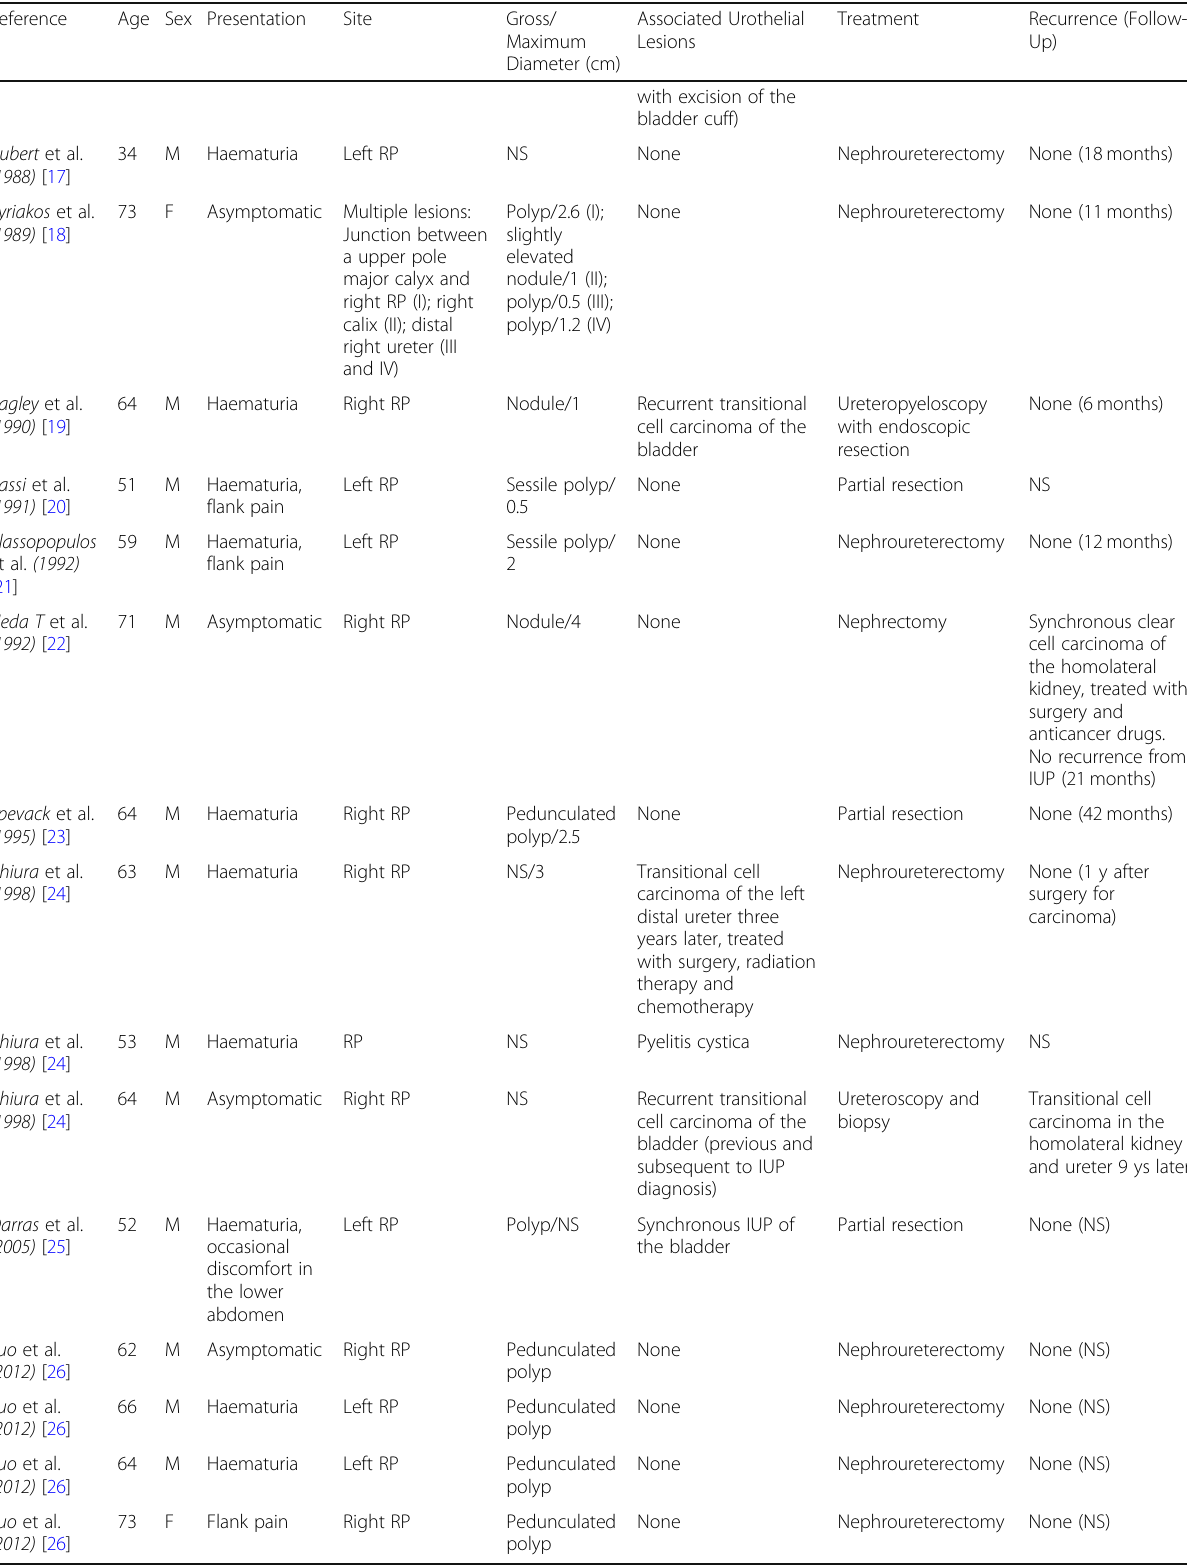
Table 1 IUP of the renal pelvis (RP) previously reported in the English Literature (NS = Not Stated; NA = Not Assessed) (Continued)